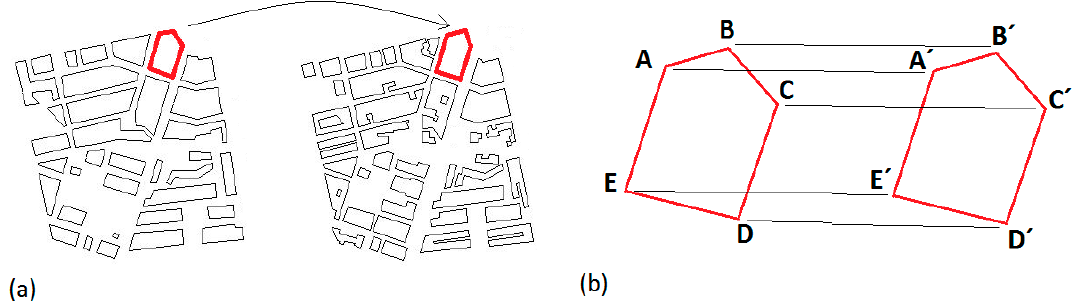
Figure 2. ( a ) Similarity between elements from both GDB and ( b ) vertex-to-vertex correspondence between the elements matched previously.